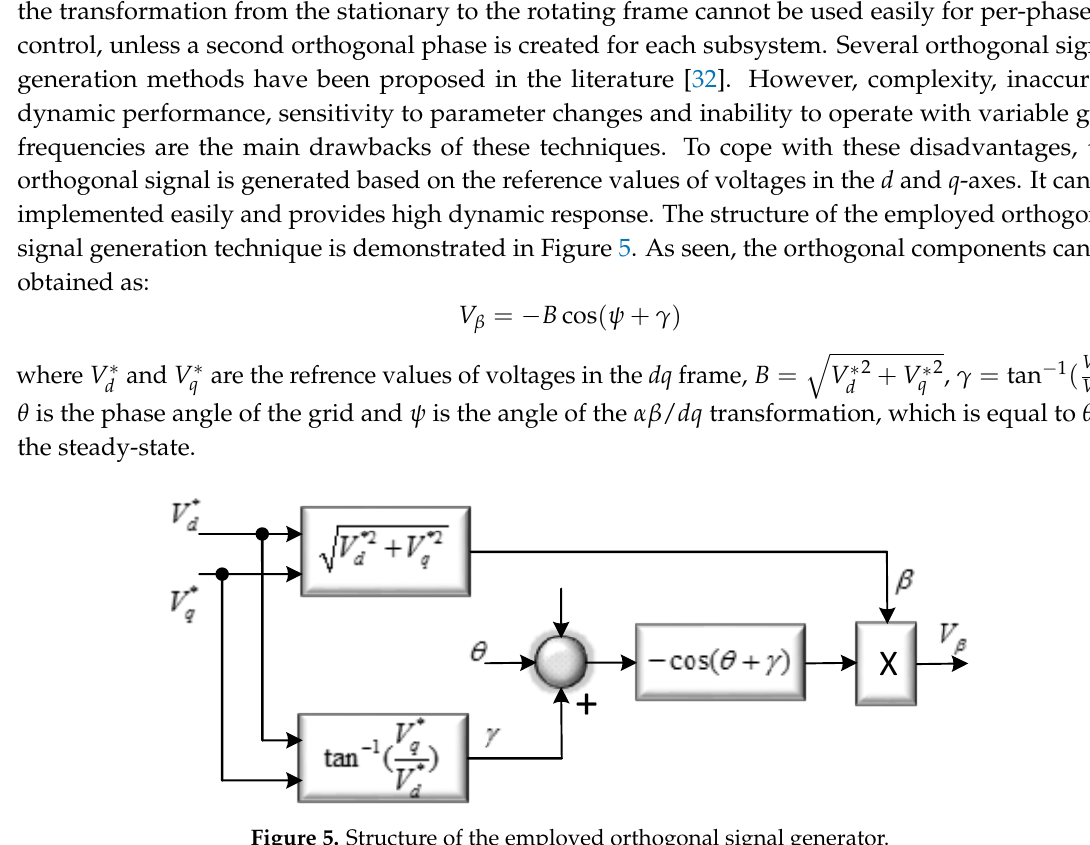
Figure 5. Structure of the employed orthogonal signal generator.